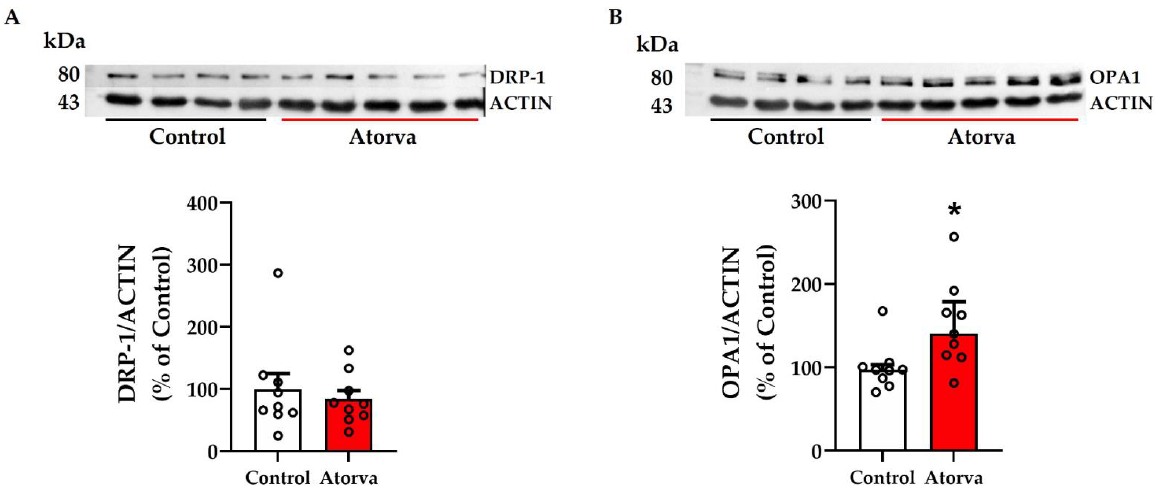
Figure 4. Representative blots pertaining to protein expression of DRP-1 ( A ) and OPA1 ( B ) in quadriceps of ApoE -/- mice fed HFHC and HFHC plus atorvastatin. Actin was used as a housekeeping. Between-group differences were assessed by Student’s t -test ( A ) and Mann-Whitney ( B ). * p < 0.05. Data are expressed as mean ± SEM ( A ) and median and interquartile range ( B ). DRP-1, dynamin related protein 1; OPA1, Optic atrophy 1. n = 9 in each group. Control = high-fat high-cholesterol diet (HFHC); Atorva = high-fat high-cholesterol diet plus atorvastatin. kDa, kilodalton. SEM, standard error of the mean.